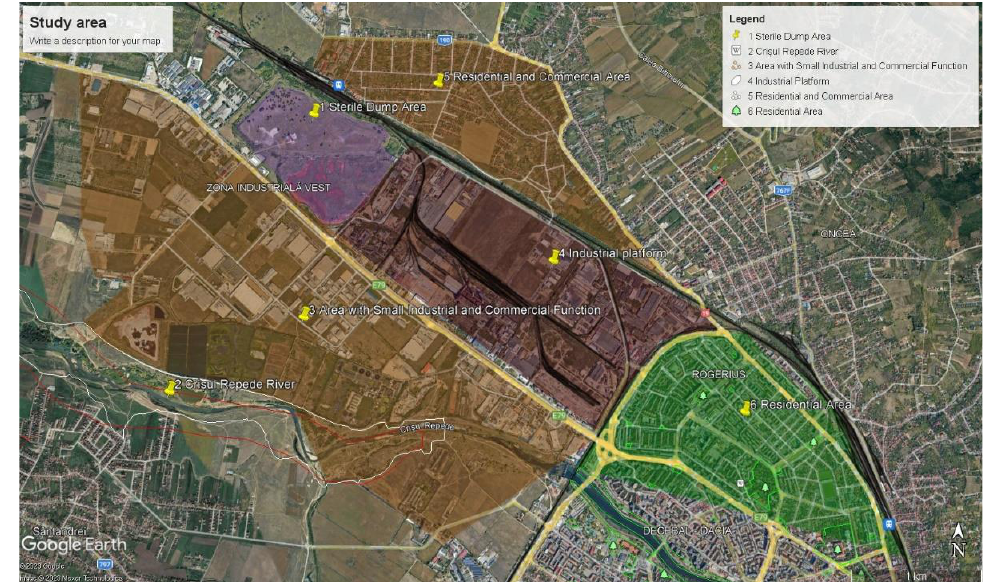
Figure 1. Research area and location of the red sludge